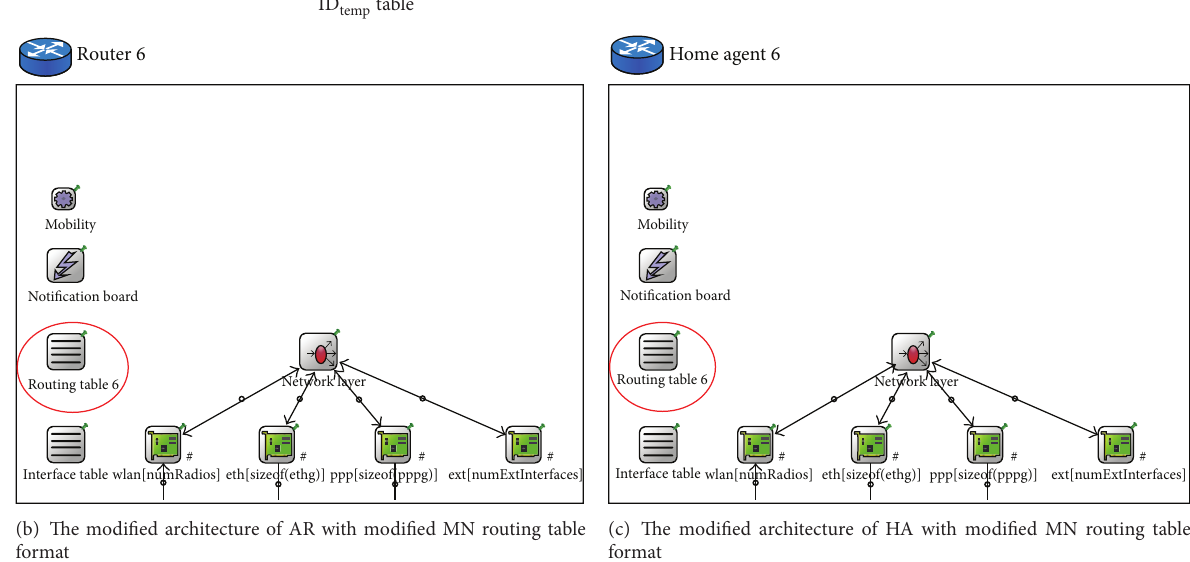
(b) The modified architecture of AR with modified MN routing table format Figure 8: Architecture design of link and network layers of AP, AR, and HA with modified AMH tables.